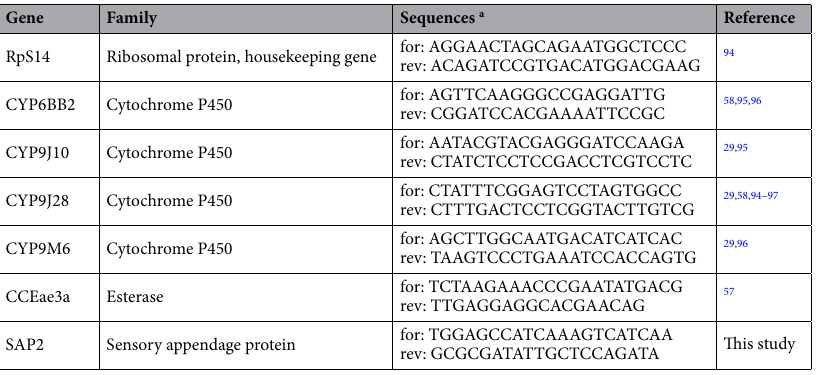
Table 5. Primers employed in gene expression analyses. a All sequences are in 5 ′ -3 ′ sense. For and rev indicate forward and reverse,